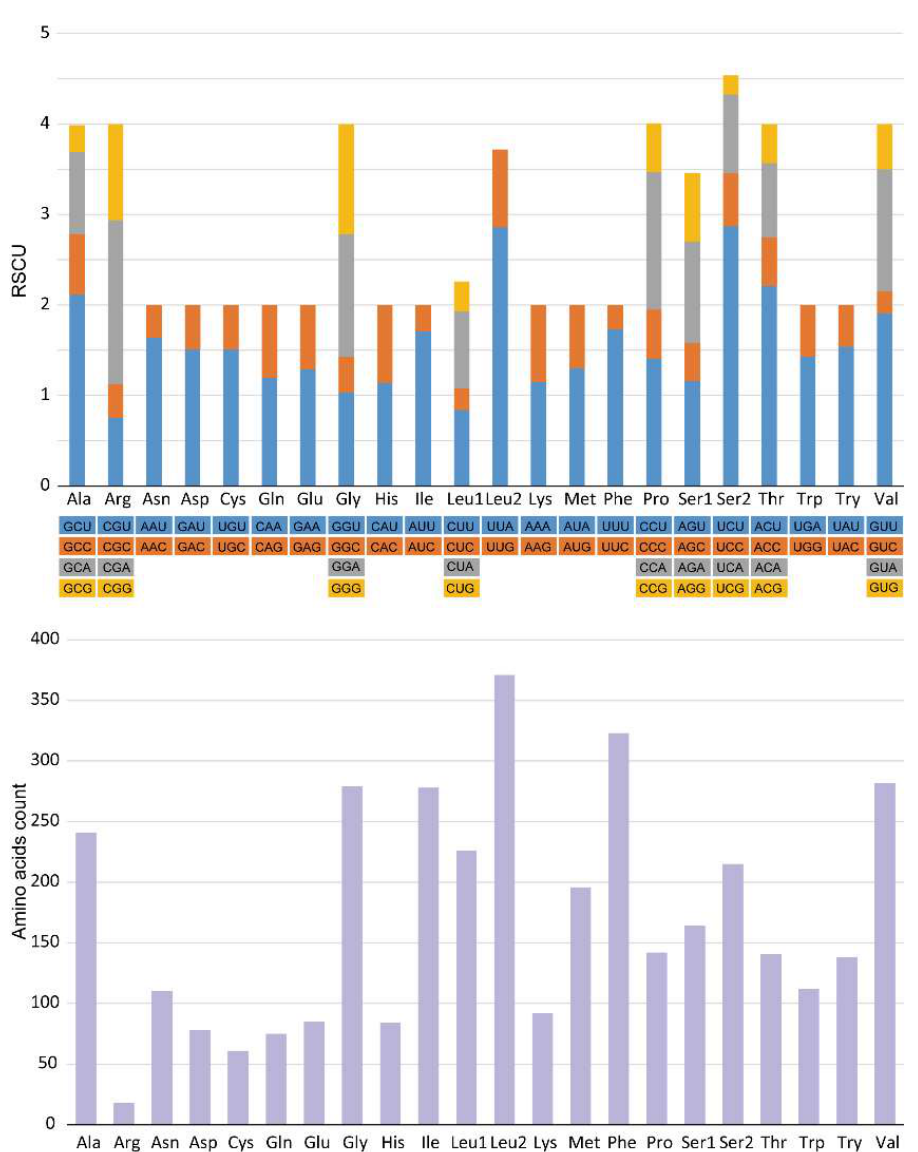
Figure 2. Relative synonymous codon usage (RSCU) and amino acids count of E. rumphii mitochondrial genome.